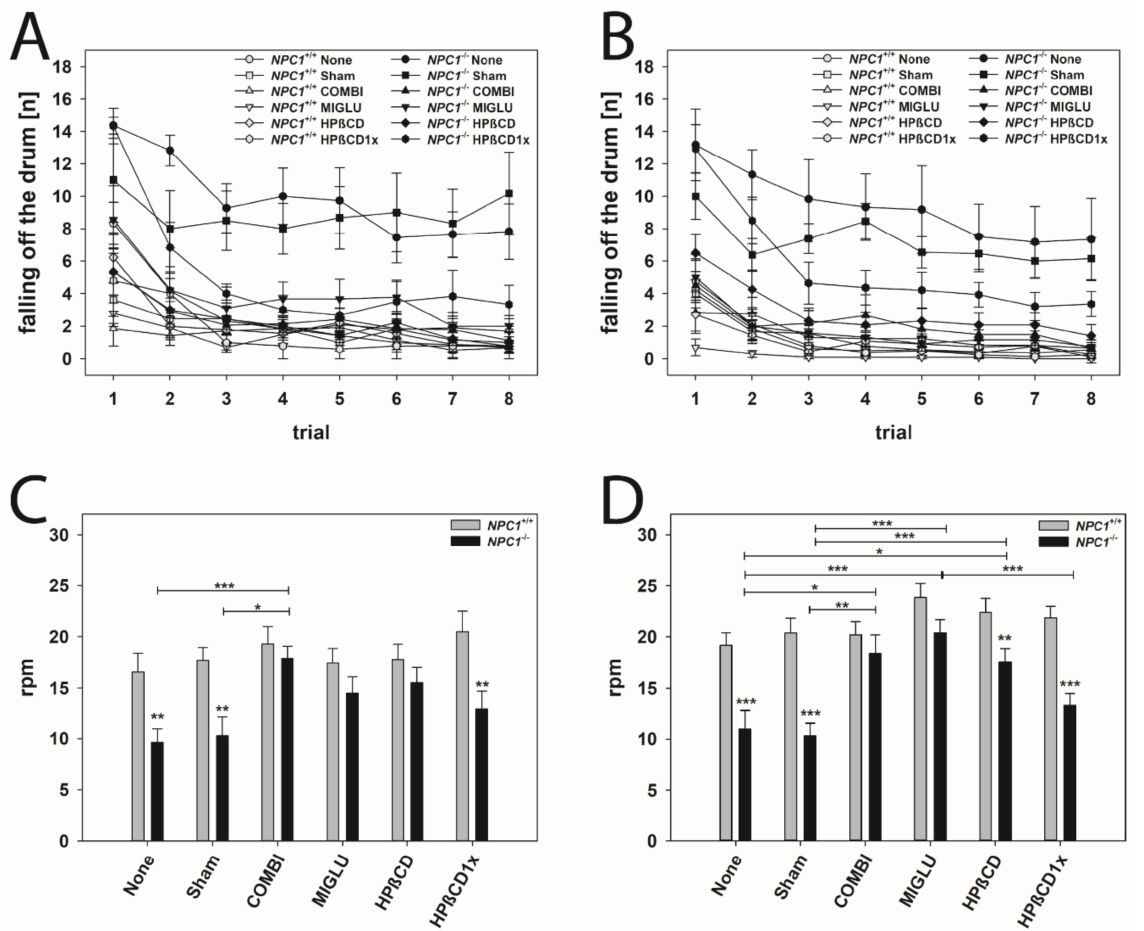
Figure 5. Accelerod training ( A , B ) and test ( C , D ) revealed an obvious motoric phenotype of NPC1 − / − mice that was improved by all treatment options. Male ( A , C ) and female ( B , D ) NPC1 mice. Significant post-hoc tests are indicated by asterisks (* p < 0.05, ** p < 0.01, *** p < 0.001). Data are means ±